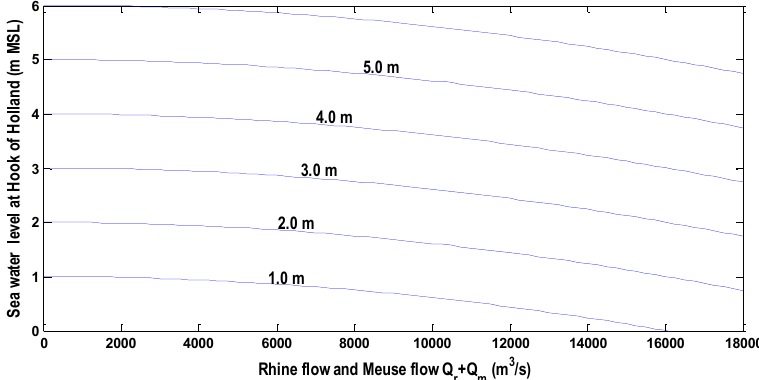
Figure A3. Equal Level Curves with the open delta at Rotterdam.